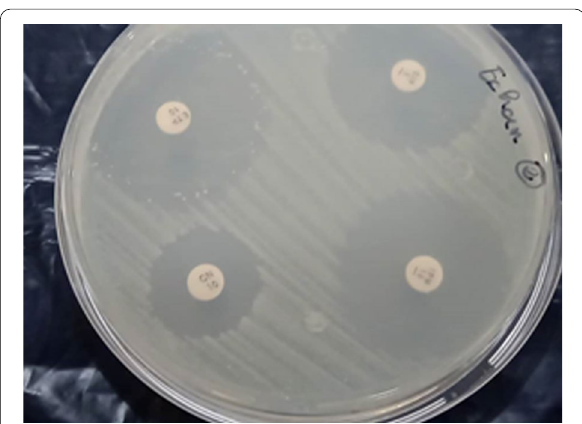
Fig. 1 Plate showing average diameters of inhibition zones